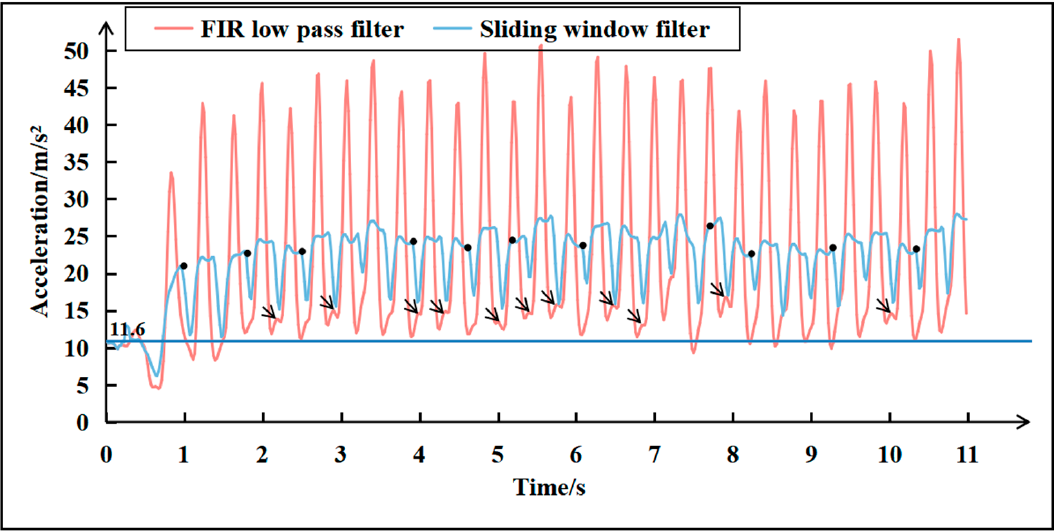
Figure 7. Pseudo ‐ peak elimination by adaptive threshold in running state. Figure 7. Pseudo-peak elimination by adaptive threshold in running